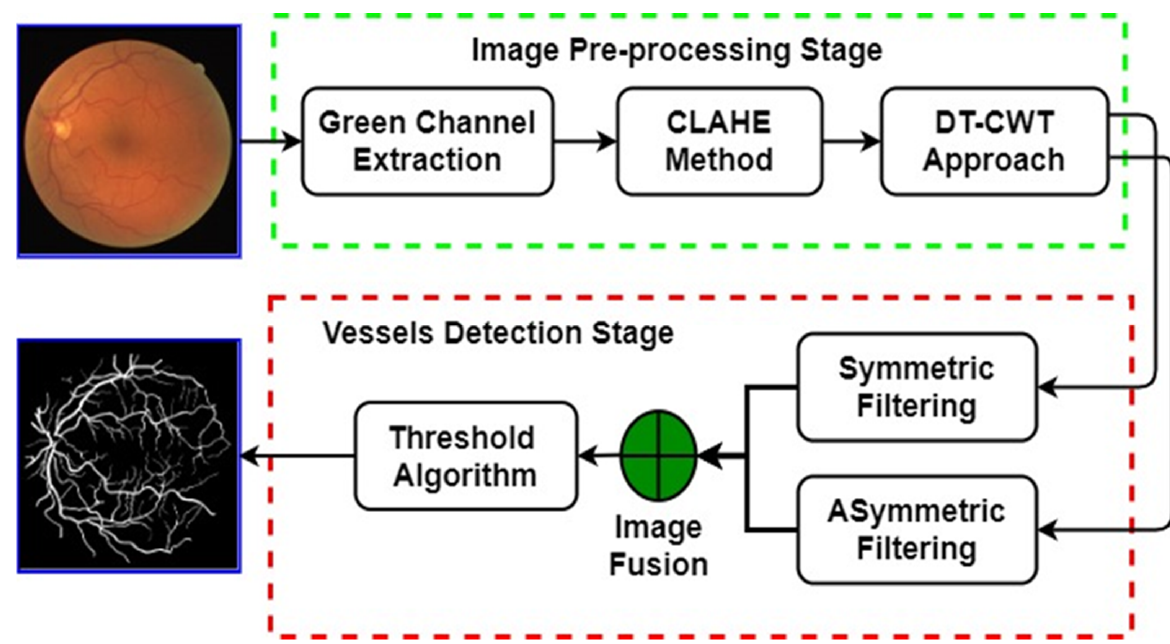
Figure 2. The fundamental stages of the proposed trainable filtering algorithm for detecting the retinal blood vessels.